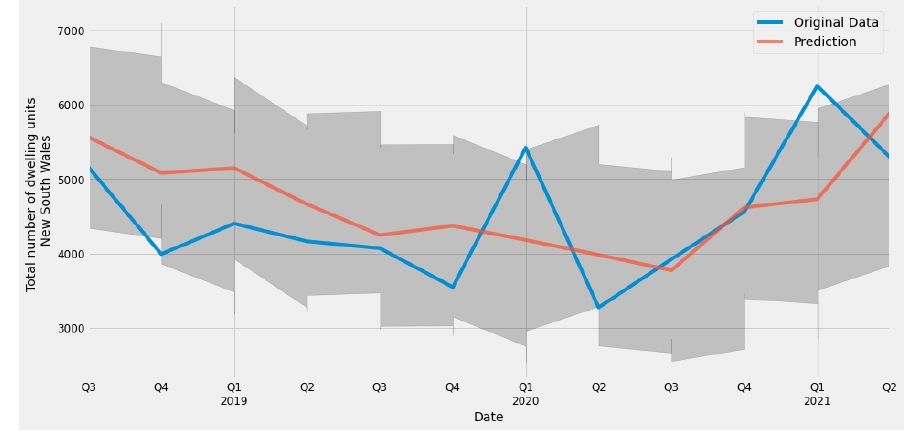
Figure 10. SARIMA-based prediction